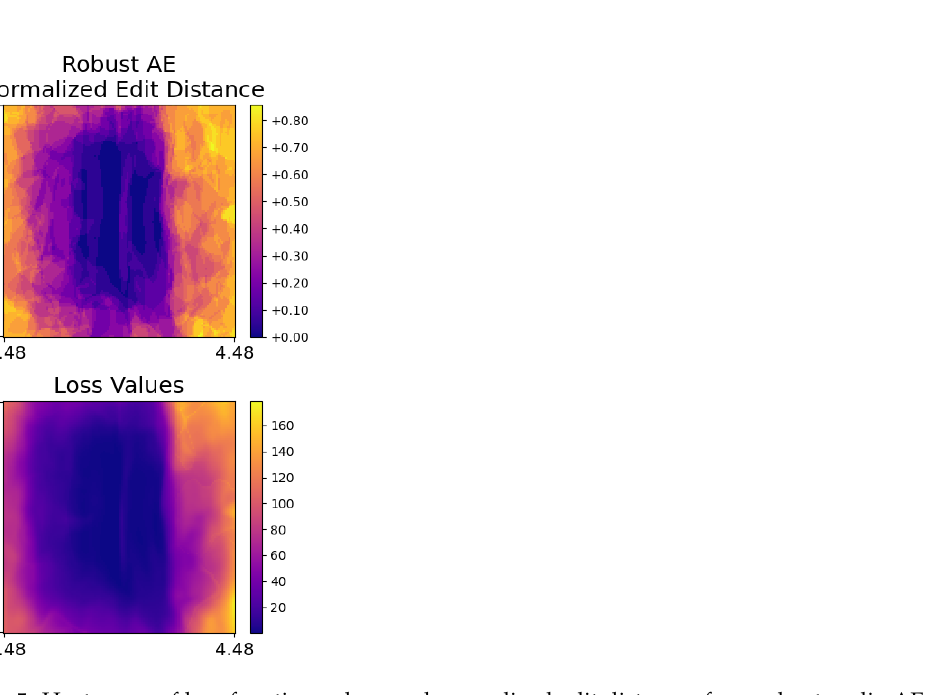
Figure 5. Heat maps of loss function values and normalized edit distances for a robust audio AE. There are small changes in loss function values and normalized edit distances when this robust audio AE is slightly modified.